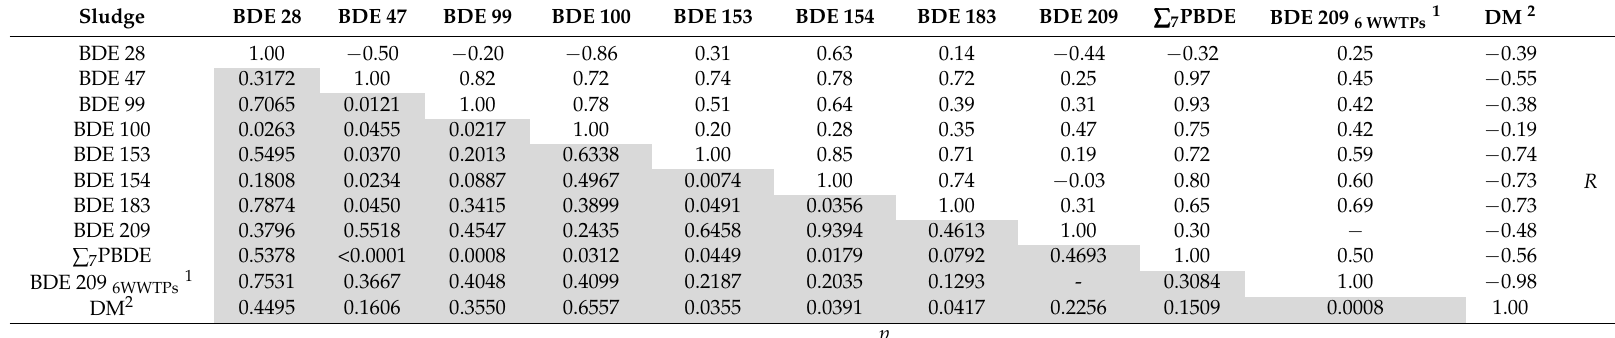
Table 3. Pearson correlation coefficients and p -values calculated for PBDE concentrations and the content of dry matter analyzed in sewage sludge samples.